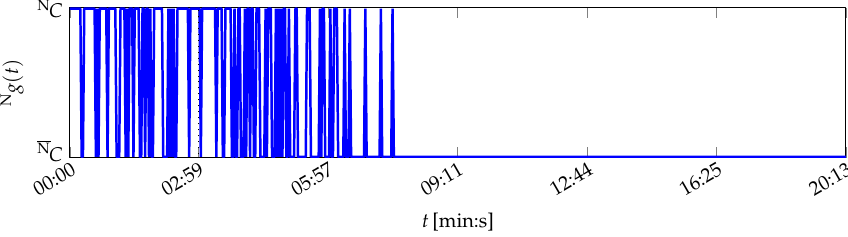
Figure 7. System health evaluation over time during static operation of the printing unit demonstrator (PU static ) by one-class